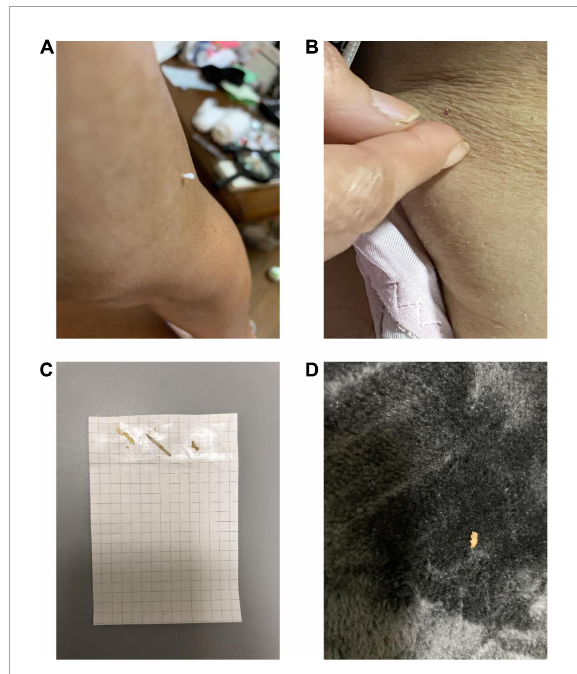
“matchbox sign”. (A,B) Picture of an object on her skin. (C) She pasted the object onto a paper and (D) found the object on the